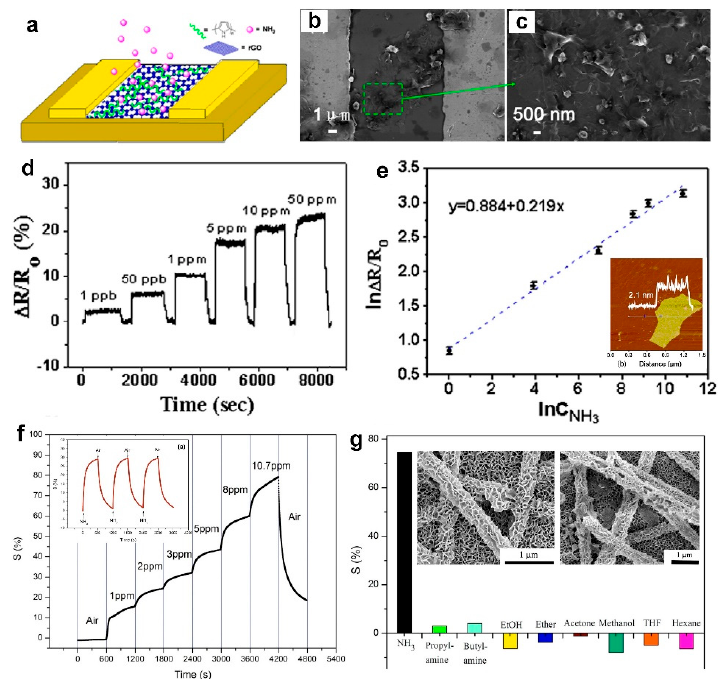
Figure 10. ( a ) Schematic diagram of the gas sensors based on rGO. ( b ) SEM image of a sensing device composed of rGO platelets that bridge neighboring Au fingers. ( c ) An enlarged image of rGO membrane formed between electrodes. ( d ) Plot of normalized resistance change versus time for the sensing device based on rGO upon exposure to NH 3 gas with concentrations ranging from 1 ppb to 50 ppm. ( e ) Log–log plot of response variation of the rGO sensor as a function of NH 3 concentration [62]. ( f ) Dynamic responses of SnO 2 /PPy nanocomposite to different NH 3 concentrations at room temperature. Inset: Sensor’s response to 5 ppm of NH 3 at room temperature. ( g ) Response magnitude of SnO 2 /PPy nanocomposite to different vapors at room temperature. Concentration of the vapors: [NH3] = 10.7 ppm. [Propyl amine] = [butyl amine] = 10 ppm. 5000 ppm for other organic solvents. Inset: SEM images of electrospun nanofibers before (left) and after hydrothermal treatment at 135 °C for 8 hours [65].